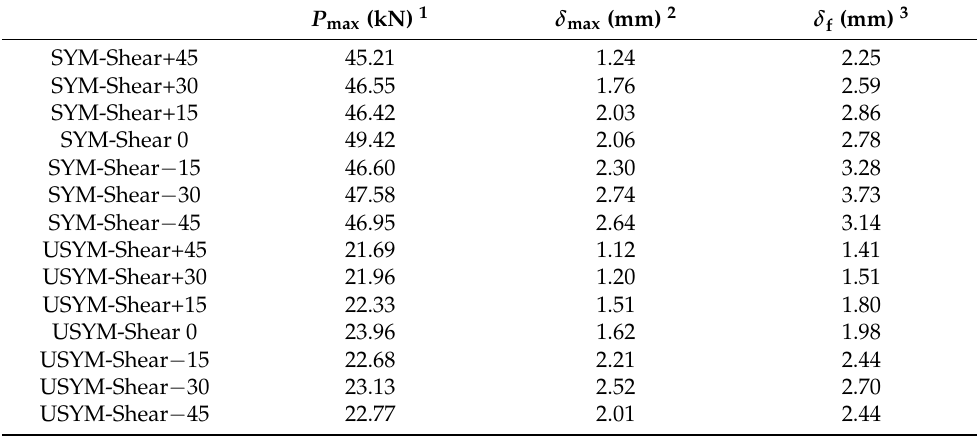
Figure 7. Load-displacement curves of SM570 steel: ( a ) SYM-Shear specimen; ( b ) USYM-Shear specimen. Table 2. Mean values of the test results obtained for SM570.